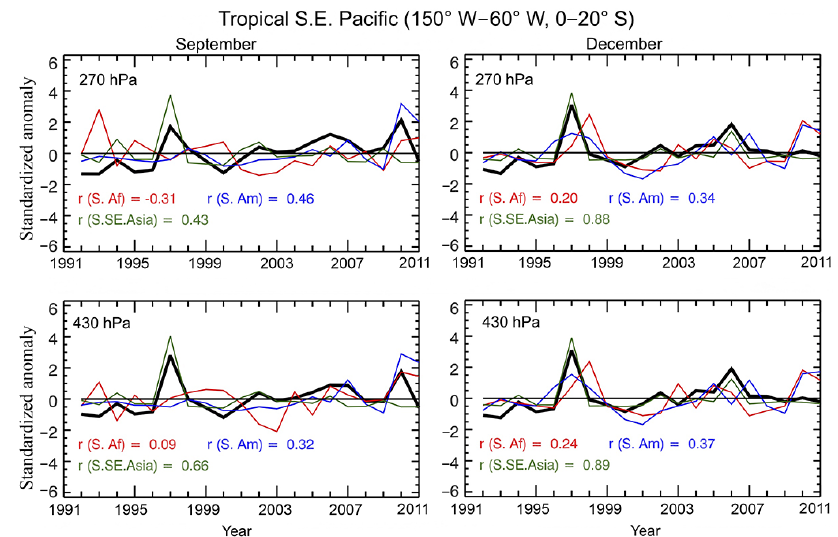
Figure 18. The standardized anomalies of the tagged CO tracers over the tropical southeastern Pacific region from three burning regions, including southern Africa (red), South America (blue), and South and Southeast Asia (green), and their comparison with the EmissO 3 (black) at 270 and 430hPa in September and December from 1992 to 2011.